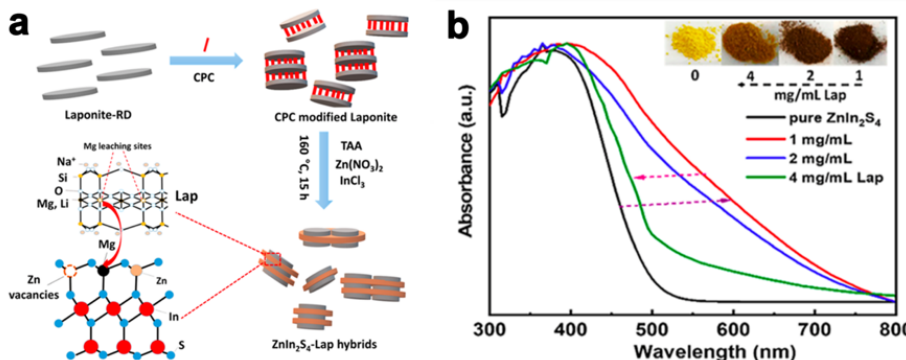
Figure 2. ( a ) Schematic illustration of ZnIn 2 S 4 –Laponite synthesis, where CPC and Lap represent cetylpyridinium chloride and laponite, respectively. ( b ) UV–vis diffuse reflectance spectra of inset samples with different amounts of Laponite at 1, 2, and 4 mg mL − 1 , respectively. Reprinted with permission from Ref. [54]. Copyright 2021, American Chemical